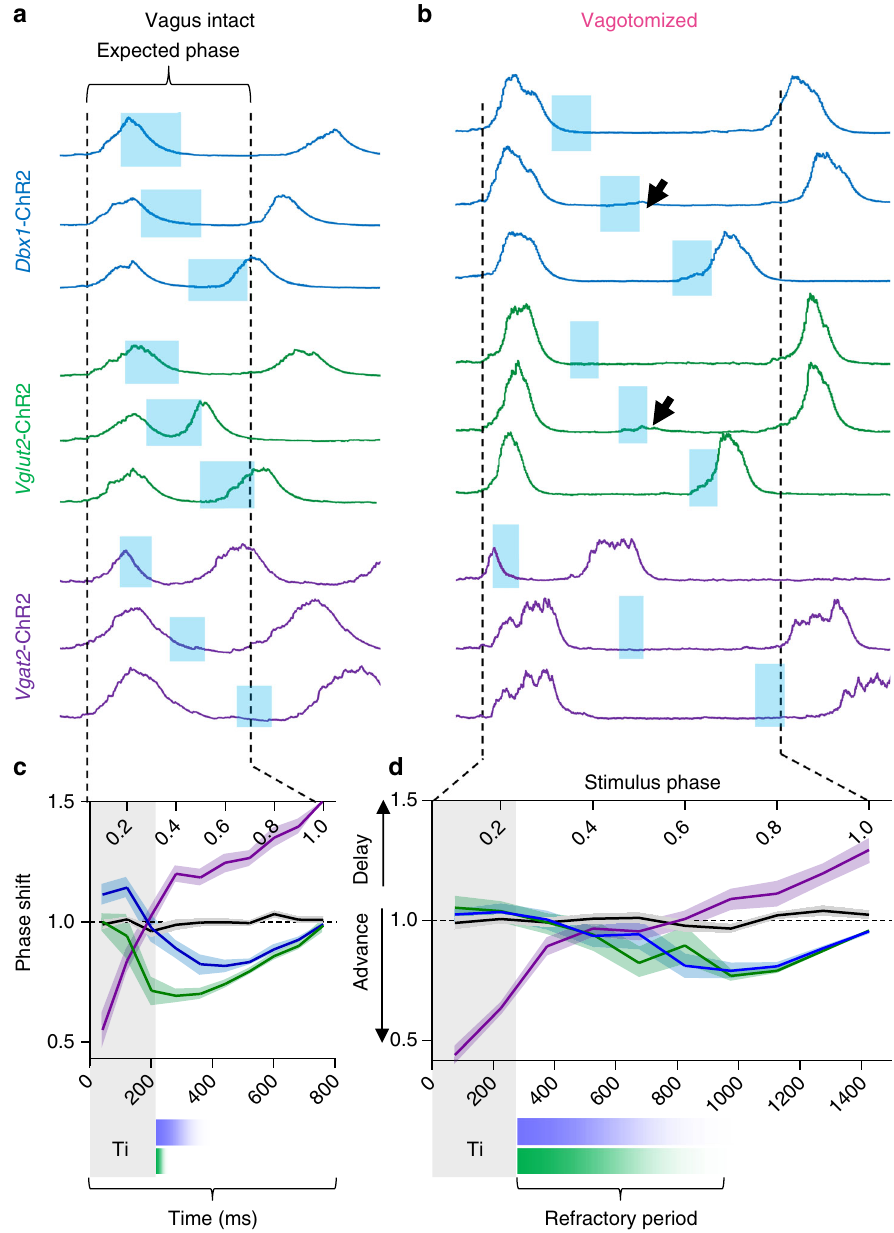
Fig. 9 Vagal sensory feedback limits the refractory period for excitatory preBötC populations. a , b Example integrated XII nerve activity during brief (100 – 200 ms) light stimulation at different time points within the respiratory cycle in vagus-intact ( a ) and vagotomized ( b ) Dbx1 -ChR2, Vglut2 -ChR2, and Vgat -ChR2 mice. Note the difference in the refractory period for partially overlapping Vglut and Dbx1 populations in vagus-intact mice. Arrows indicate failed bursts near the end of the refractory period. Traces are scaled to the expected duration of the respiratory cycle (expected phase). c , d Quanti fi ed phase shift elicited during stimulations across the respiratory cycle (stimulus phase 0 = beginning of inspiration) in vagus-intact ( c ) (Dbx1, n = 10; Vglut2, n = 10; Vgat, n = 5; Cre − , n = 9) and vagotomized mice ( d ) ( Dbx1 , n = 9; Vglut2, n = 7; Vgat, n = 3; Cre − , n = 9; mean ± s.e.m.). Data from Cre − control mice shown in black. Refractory periods for Dbx1 -ChR2 (blue) and Vglut2 -ChR2 (green) shown on equivalent time scales relative to the average respiratory cycle duration in vagus-intact and vagotomized conditions. Note the exaggerated refractory period in vagotomized mice and the minimal effect of Vgat - ChR2 stimulation during the refractory